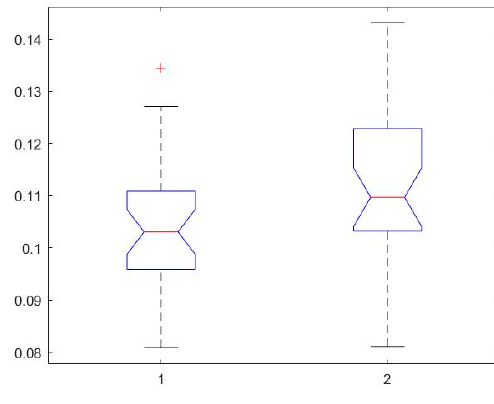
1. MAPE indicator. The result indicates a similarity between the MAPE values.